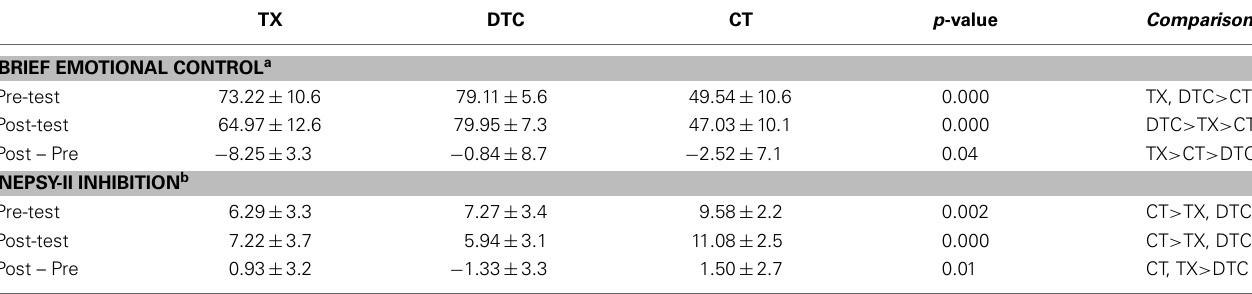
Table 2 | Descriptive statistics for BRIEF and NEPSY-II